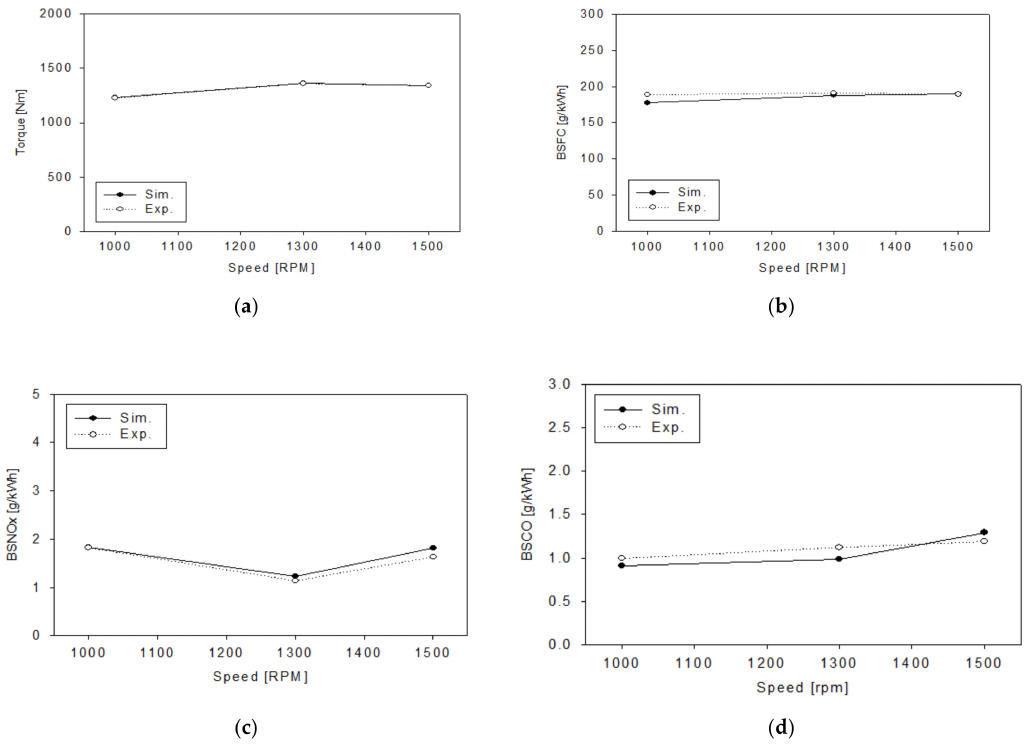
Figure 3. Validation results for engine performance and emission: ( a ) brake torque; ( b ); BSFC; ( c ) BSNOx; ( d ) BSCO.